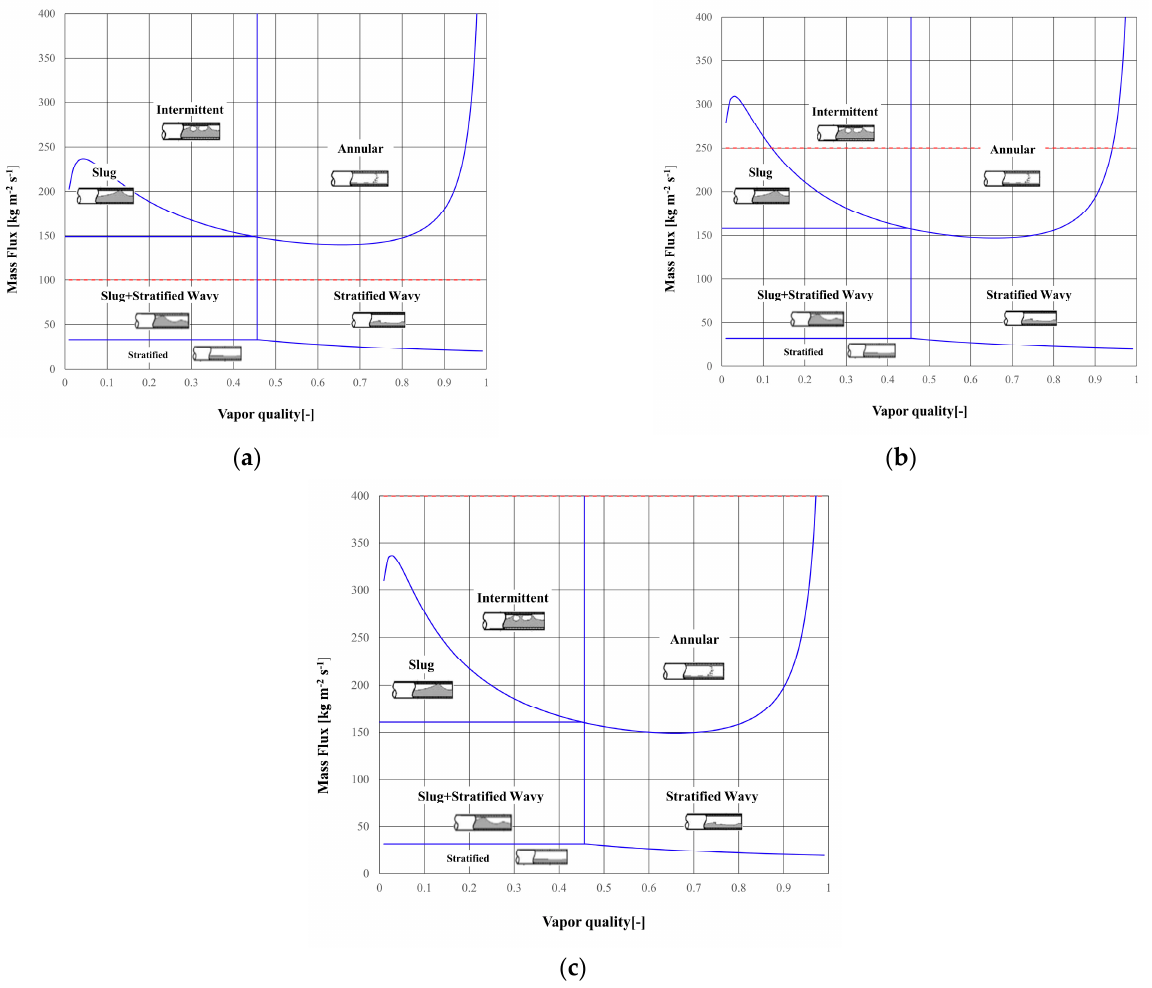
Figure 1. Schematic diagram of the experimental apparatus .